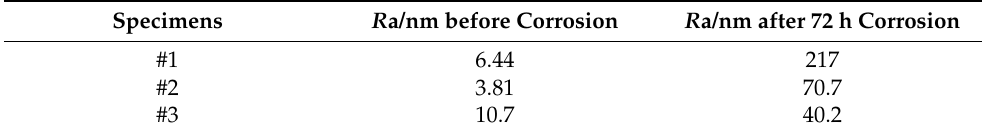
Table 2. The roughness R a of specimens #1~#3 surface before and after corrosion. Specimens